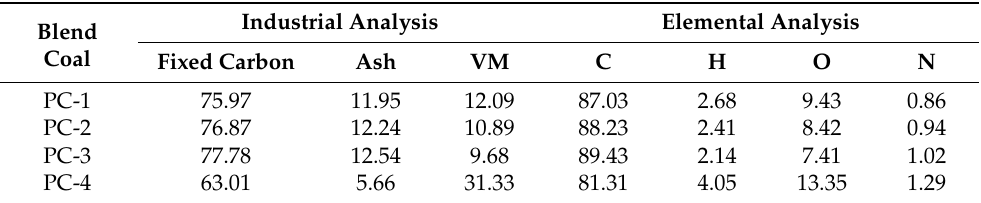
Table 6. Composition of blended coal under different simulation